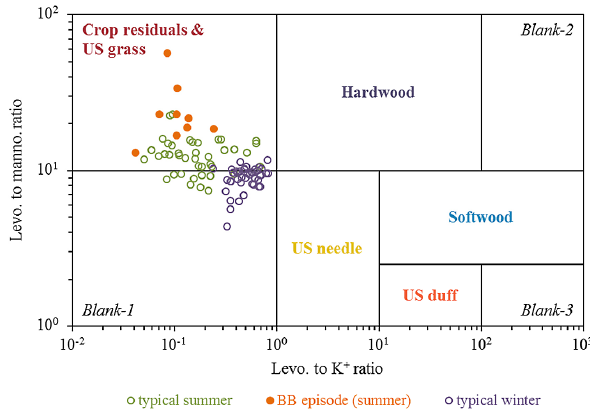
Fig. 9. Representative ranges of the levoglucosan to K + and the levoglucosan to mannosan ratios for different kinds of biomass. Re- sults from the ambient samples collected in Beijing are also shown for